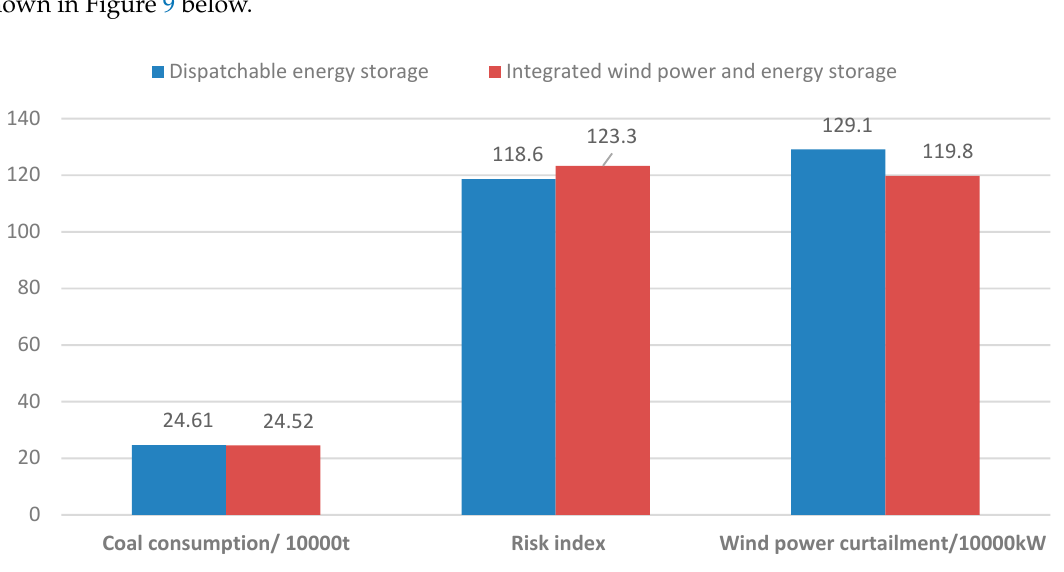
Figure 9. Comparison of the risk scheduling results between two kinds of operation modes with integrated wind power and energy storage.